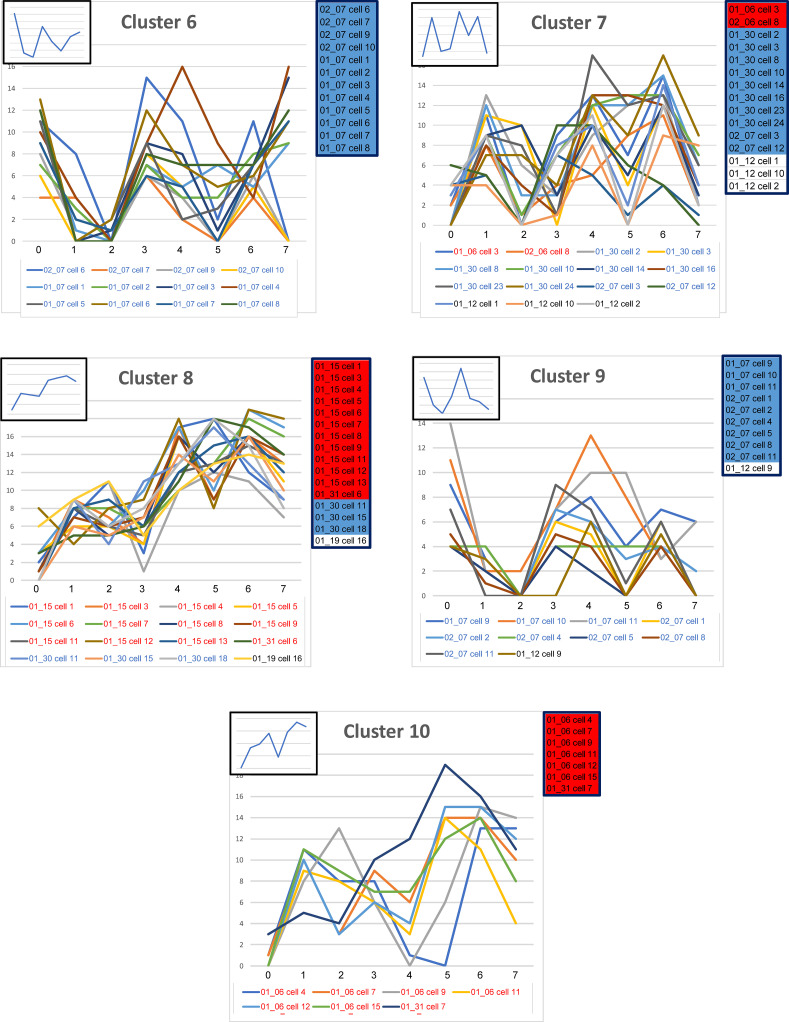
Profiles for clusters 6–10 (out of 10).Graphs are shown for clusters 6–10. See legend for Figure 8 for details.